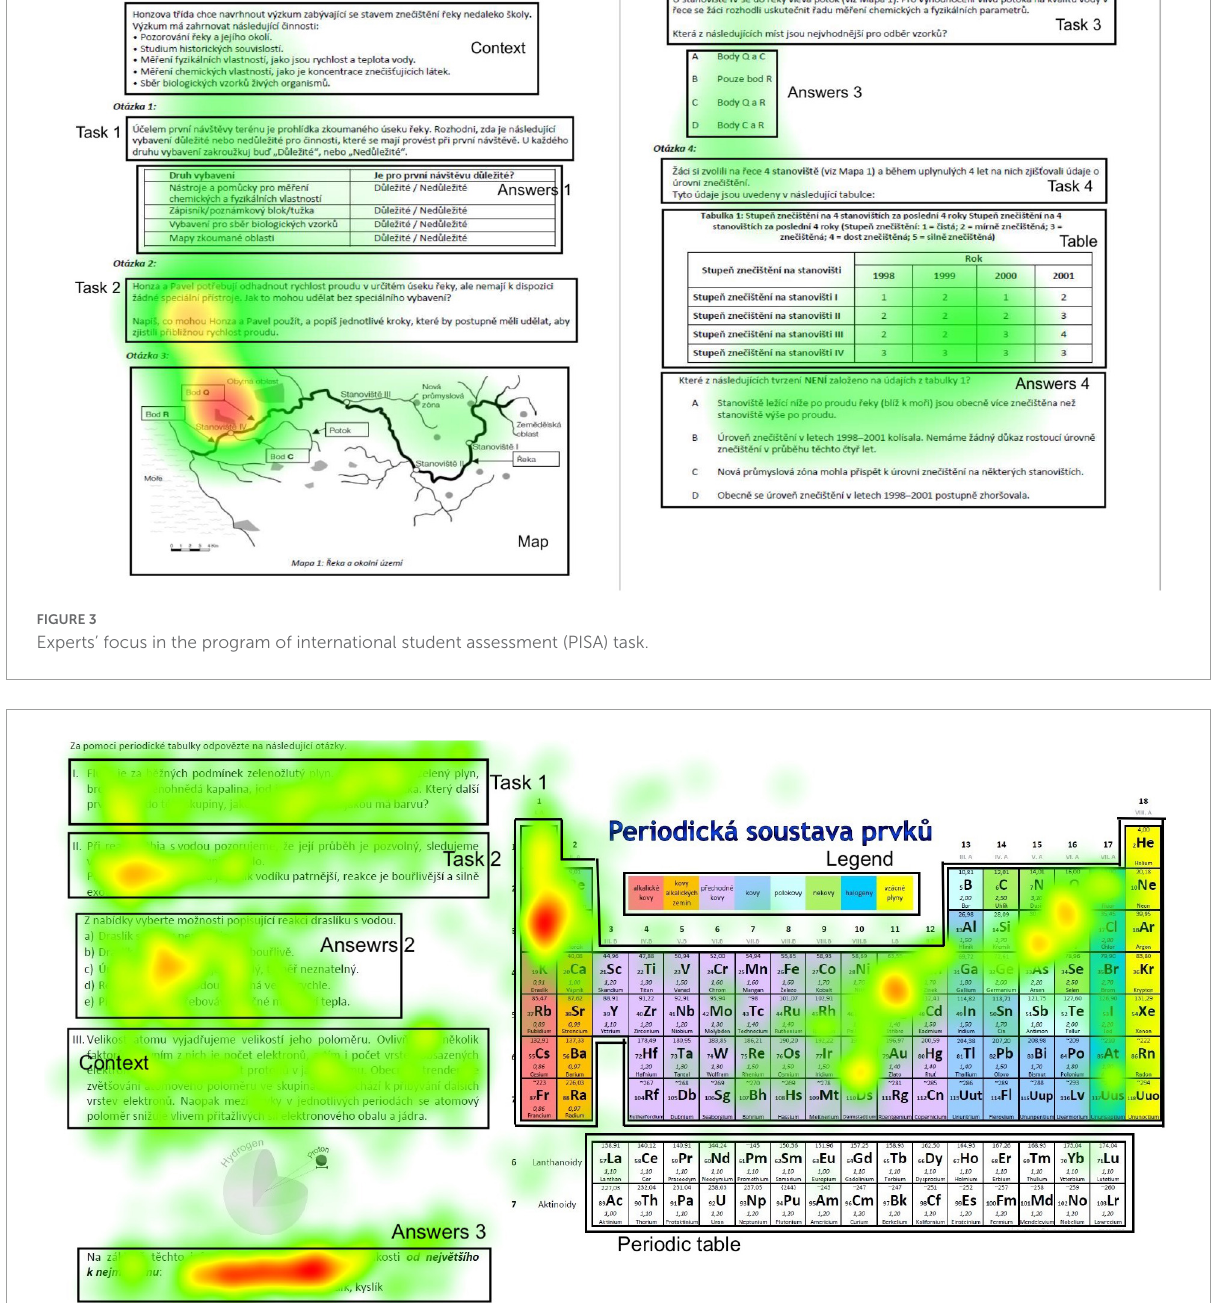
FIGURE4 Students’ focus in the program of international student assessment (PISA)